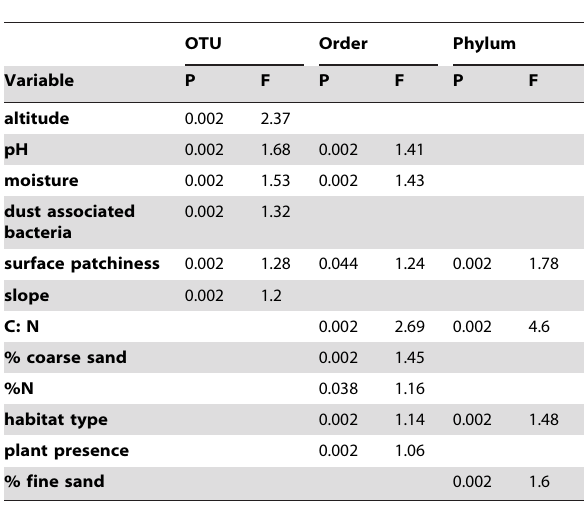
Table 1. Conditional effects of environmental variables selected by forward selection in redundancy analysis (RDA) as determined by 4999 Monte Carlo permutations under the full multivariate model at the three taxonomic